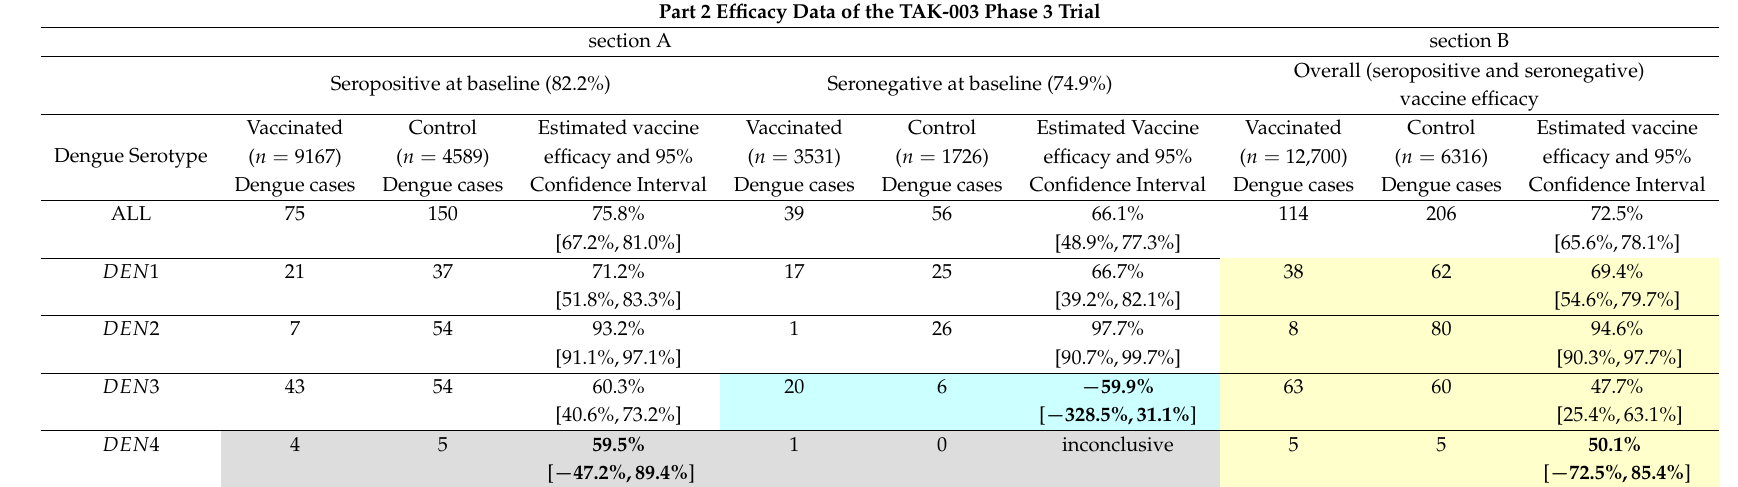
Table 2. Compilation of vaccine efficacies estimation for Takeda’s DENVax vaccine phase 3 trial post-vaccination surveillance period part 2 (18 months). Section A shows the vaccine efficacies by serostatus and serotype, and Section B shows the overall vaccine efficacy by serotype. Highlighting problems observed for serotypes 3 (blue) and 4 (grey) are indicated. The raw data used for the Bayesian analysis are available in